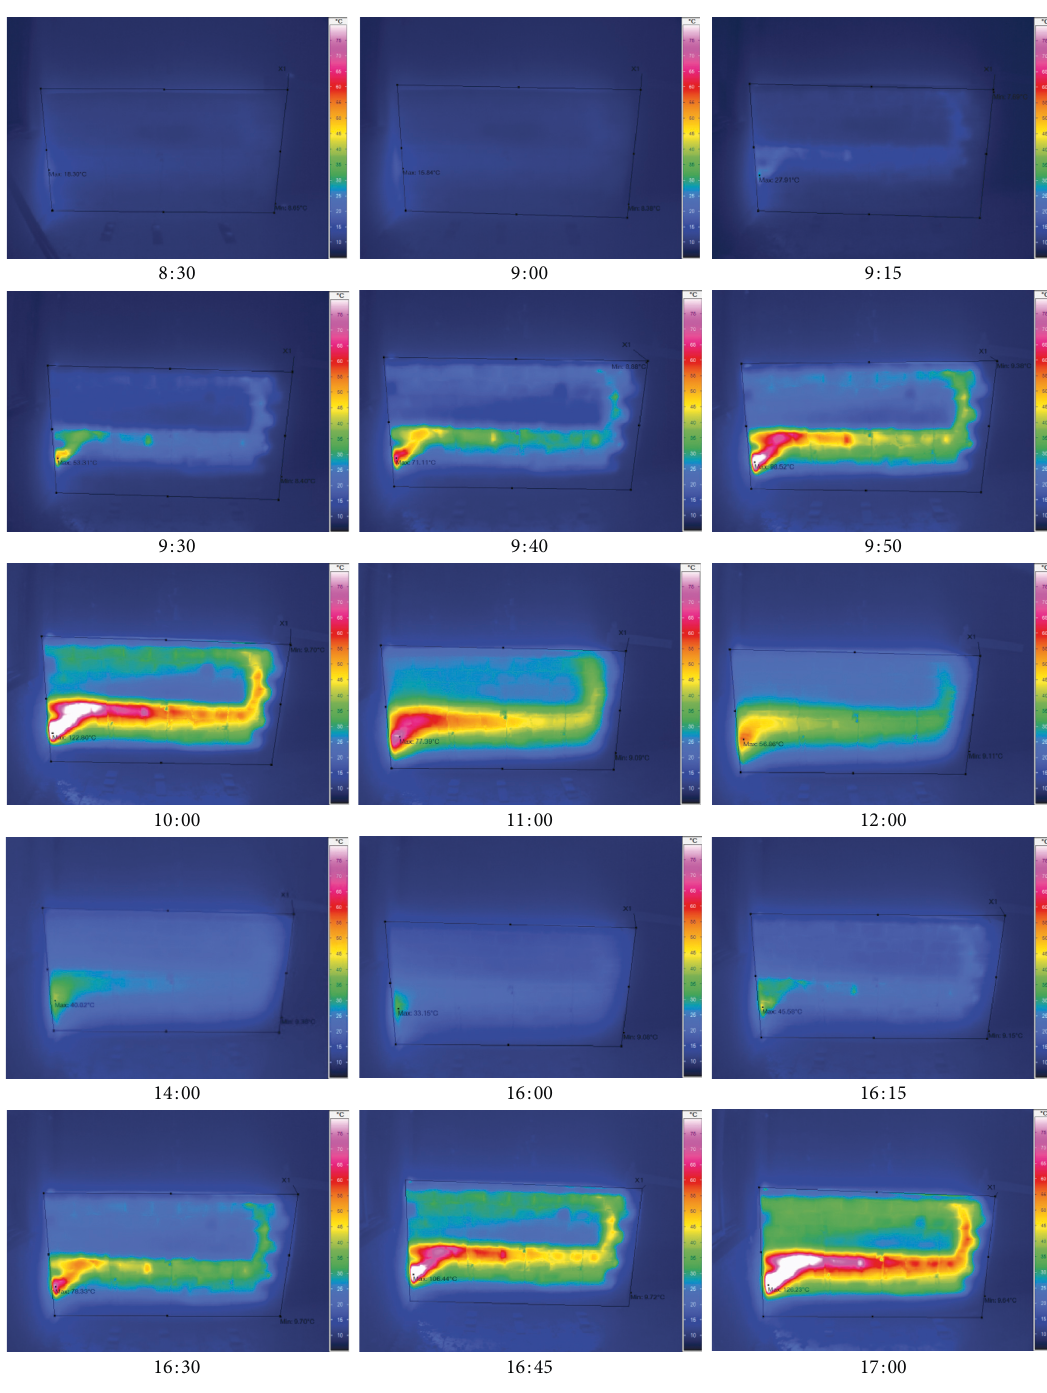
Figure 8: Infrared thermographs of a heated wall’s surface (Test